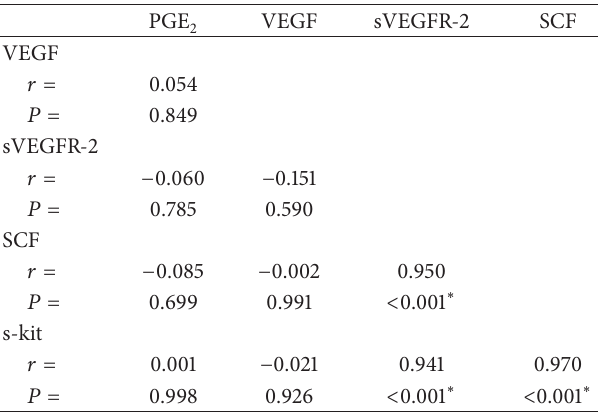
Table 5: Pearson correlation